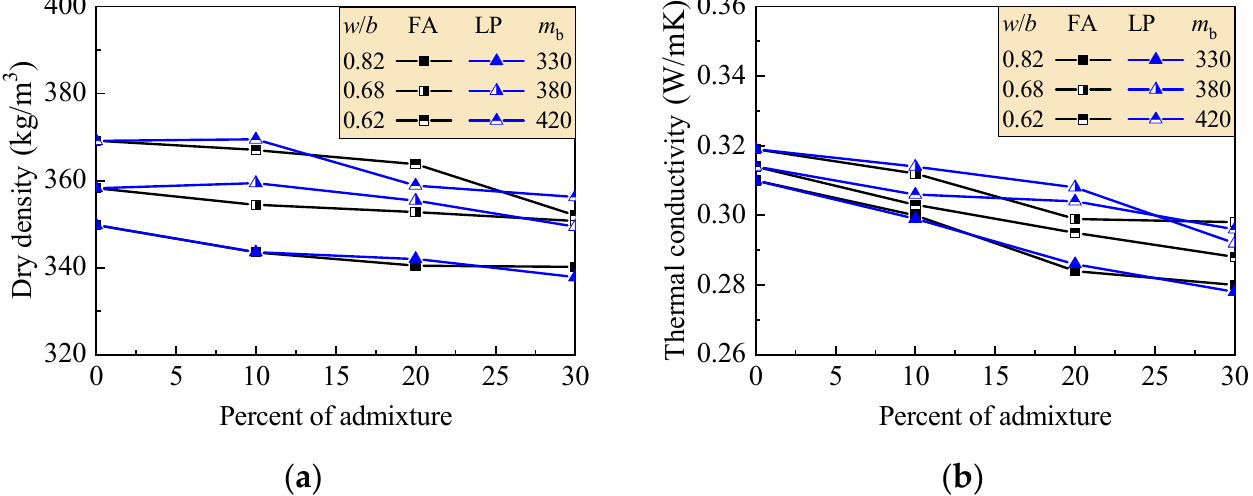
Figure 6. Test results of the compressive strength of mortars: ( a ) dry density; ( b ) thermal conductivity.